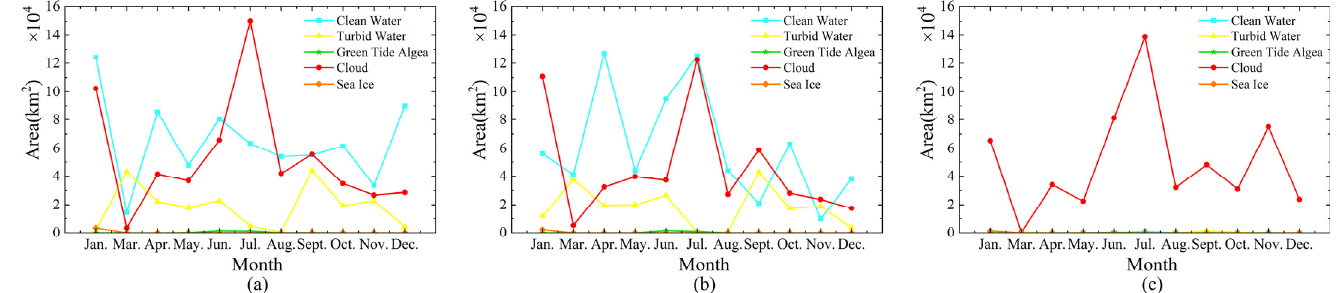
Figure 13. Schematic diagram of the month-by-month change in marine objects in the data-free areas: ( a ) GOCI, ( b ) MODIS and ( c ) OLCI.